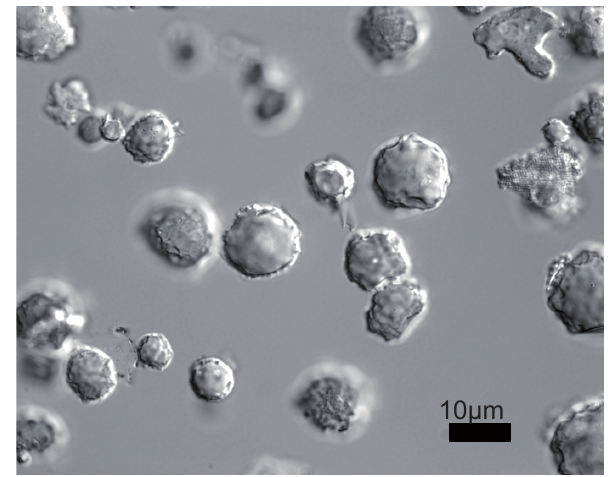
Fig. 1. Phytolith assemblage typical of rainforest, dominated by the “globular granulate” phytolith